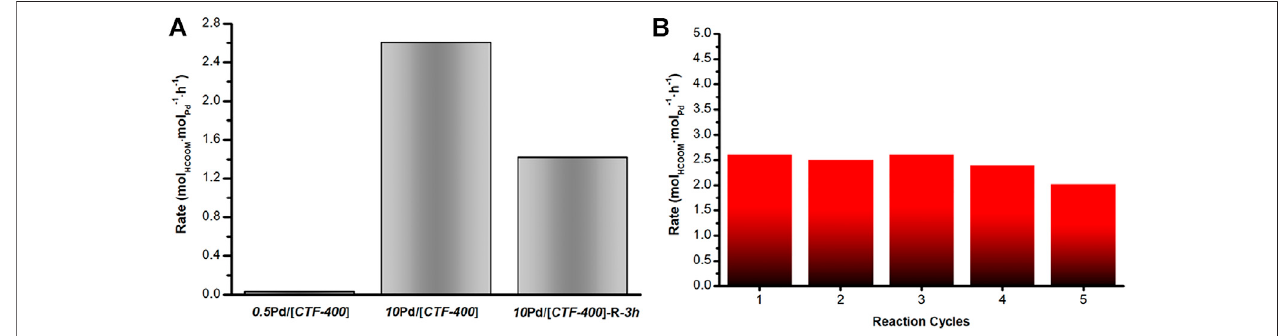
FIGURE3| CatalyticperformanceofPd/[ CTF-400 ]forthehydrogenationofcarbondioxidetoformate. (A) Formateformationrateof 0.5 Pd/[ CTF-400 ], 10 Pd/[ CTF- 400 ], and 10 Pd/[ CTF-400 ]-R- 3h . (B) Reuse test of 10 Pd/[ CTF-400 ]. Reaction conditions: 20 mg catalyst, 30 ° C, 1bar (CO 2 /H 2 = 1:1), and 5 ml NaHCO 3 (1 M), 12 h.